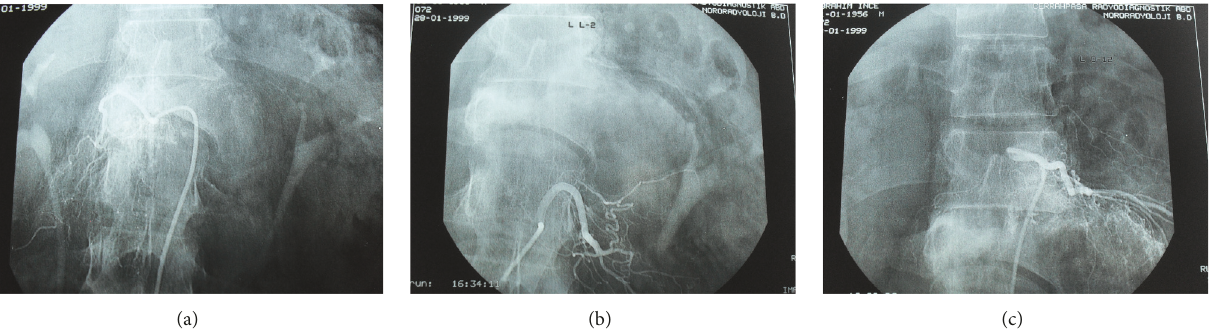
Figure 6: Successful embolization and obstruction of the right L1, left L2, and left Th12 feeders.